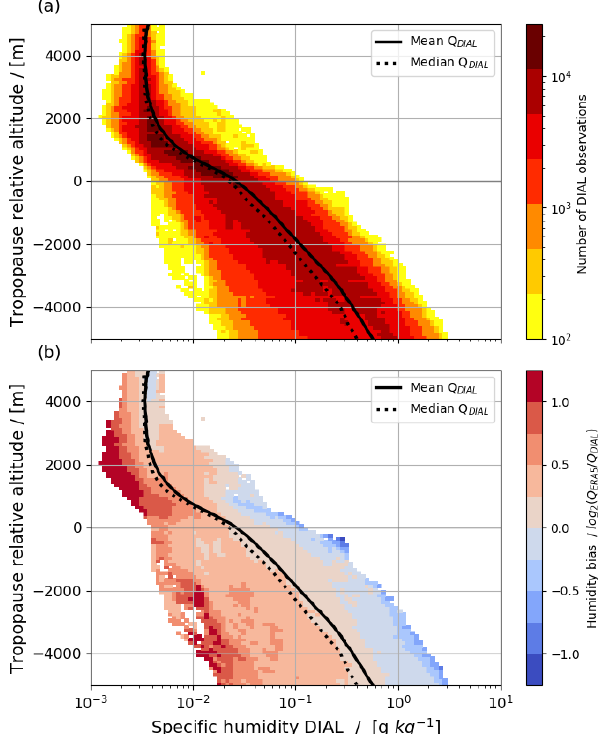
Figure 6. Binned distribution of DIAL specific humidity observa- tions relative to the thermal tropopause coloured by (a) the number of observations per bin and (b) the bin-average humidity bias. Solid thick black (dotted) lines in (a) and (b) show mean (median) val- ues per altitude bin. Bin sizes are 100m and 0.01gkg − 1 of log 10 ( q DIAL ). Please note the logarithmic abscissa and colour bar in (a)